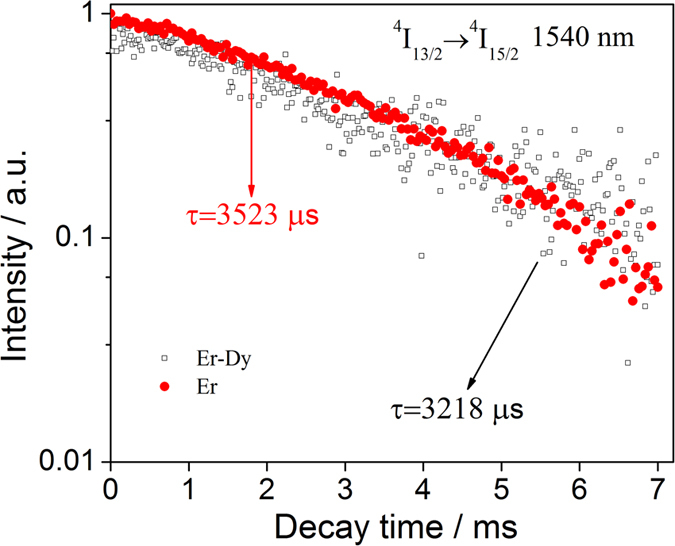
Decay curves of 4I13/2 → 4I15/2 emission (1540 nm) in Er3+-doped and Er3+-Dy3+co-doped 65GeS2–25In2S3–10CsI glasses.